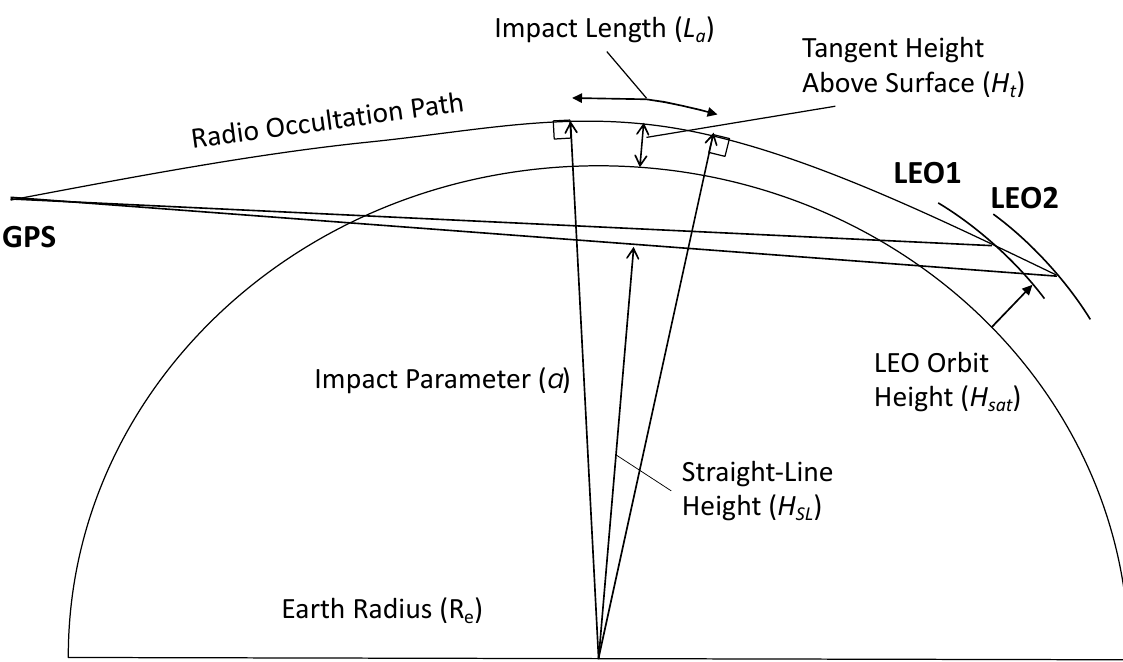
Figure 4. Diagram of the RO geometry with two LEO satellites from different orbital altitudes. For the same RO path, the two LEO receivers register the identical bending angle at different H SL heights.